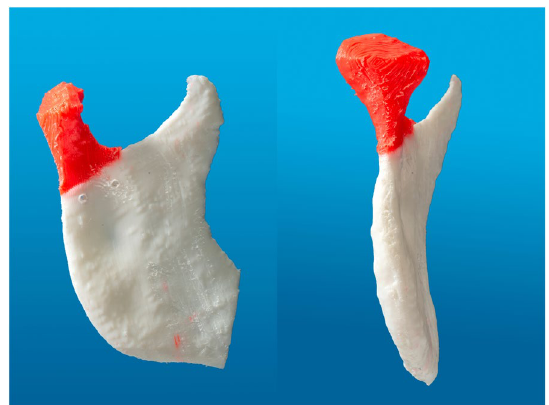
Fig. 2 Different views of the right ramus mandibulae (blue) and repositioned right cranial fragment (red); the guide structure is the mirrored ramus mandibulae from the healthy, in this case left, side (white). S, superior; I, inferior; L, left; R, right; P, posterior; A, anterior